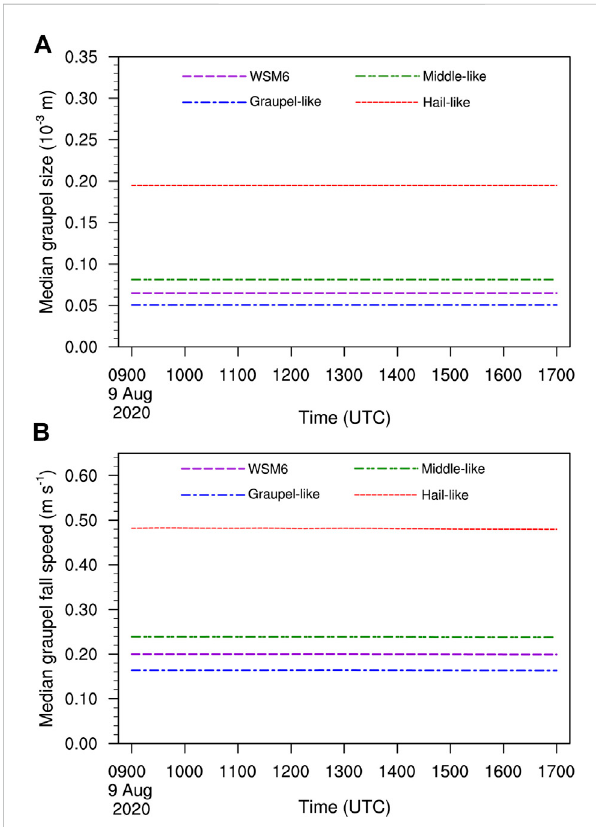
FIGURE 13 Time series of median (A) graupel sizes (10 − 3 m) and (B) graupel fallspeeds(ms − 1 )overthewholedomain shown inFigure 6forWSM6, WSM6-Graupel-Like, WSM6-Middle-Like and WSM6-Hail-Like